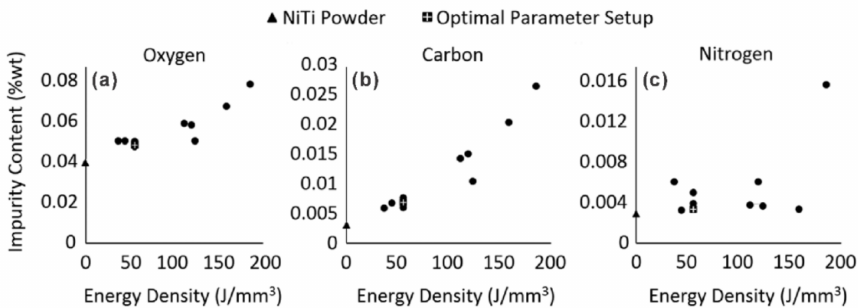
Figure 3. Oxygen, carbon, and nitrogen pickup in SLM fabricated NiTi parts [47] (with permission from SAGE